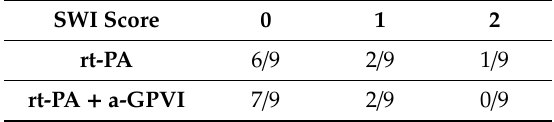
Table 1. Susceptibility weighted imaging (SWI) Score of rt-PA Treated Mice at Day1 after tMCAO. SWI Score 0